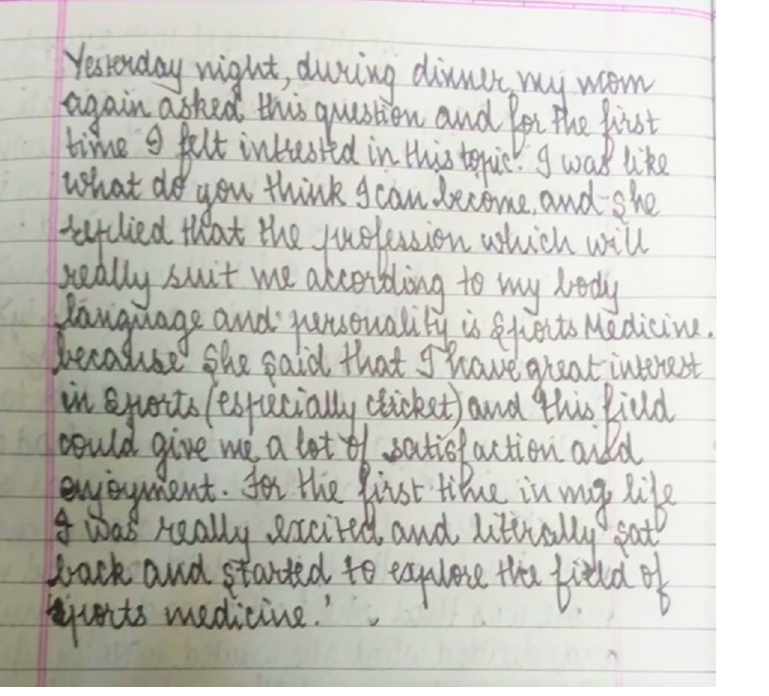
Fig 3. What do you think I can become?—Journal entry © G2, female, 15 years.